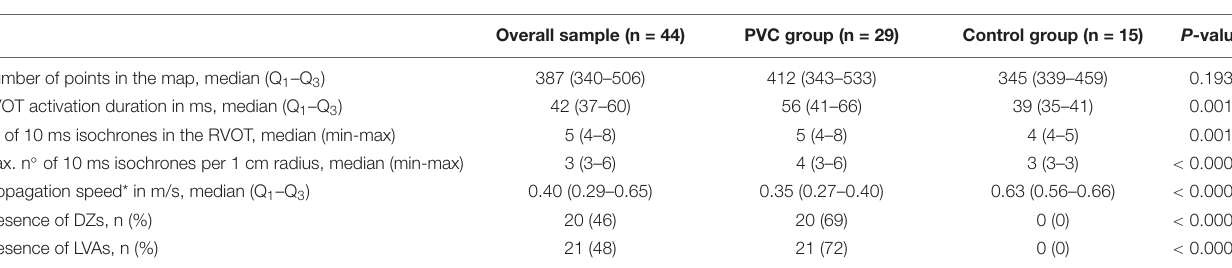
TABLE 2 | Sinus rhythm activation and voltage mapping